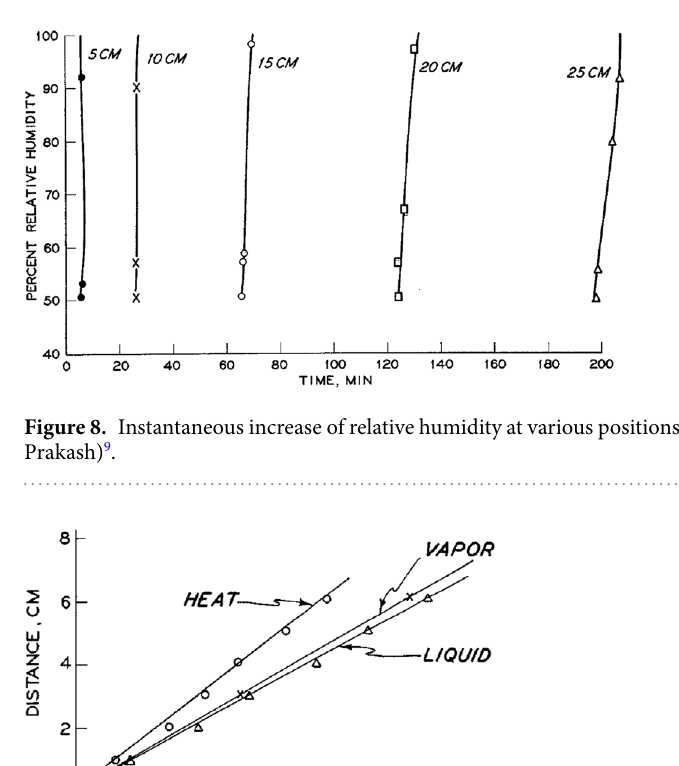
Figure 7. Temperature as a function of time measured at different locations in experiments of Perrier and Prakash 9 .